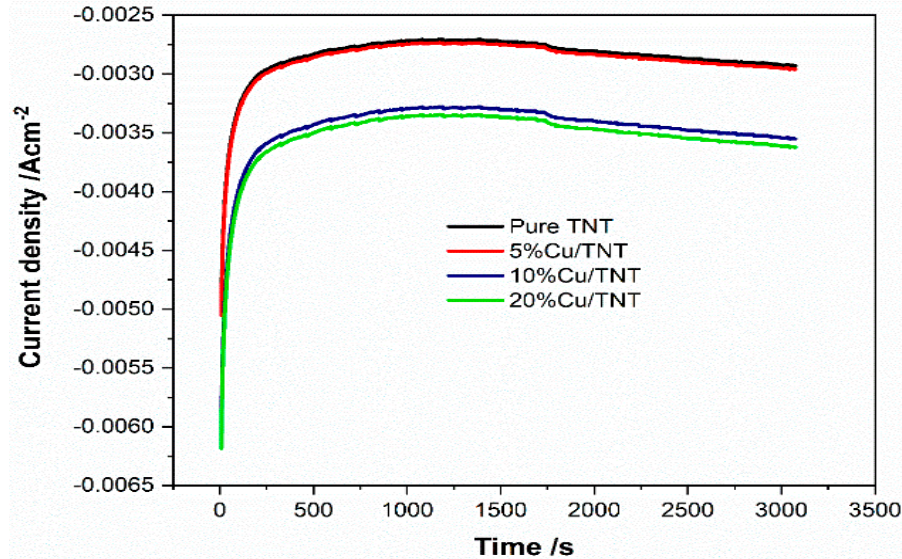
Figure 7. Chronoamperometry of the prepared catalysts at − 1.7 V vs. SCE.